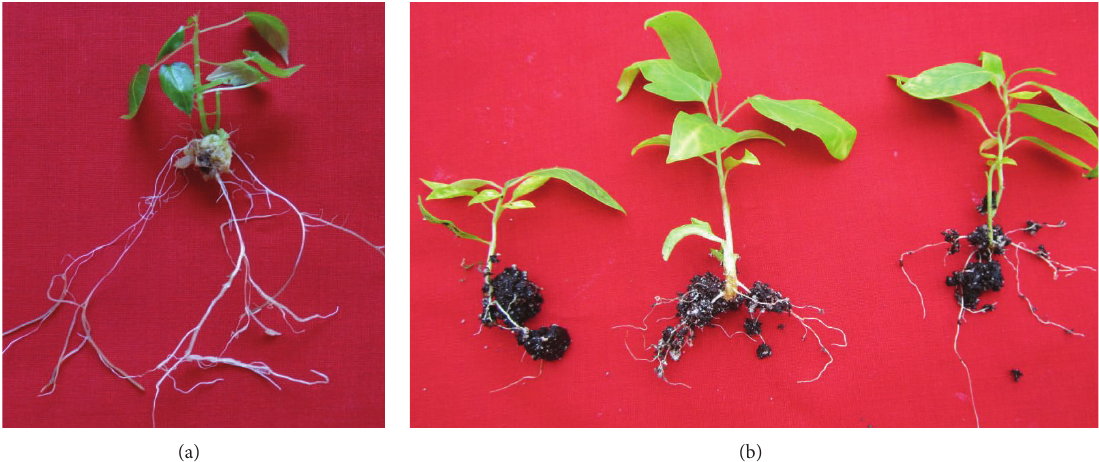
Figure 2: (a) In vitro root induction from the shoots on half strength MS medium with IBA. (b) Ex vitro root formation in the greenhouse after four weeks.